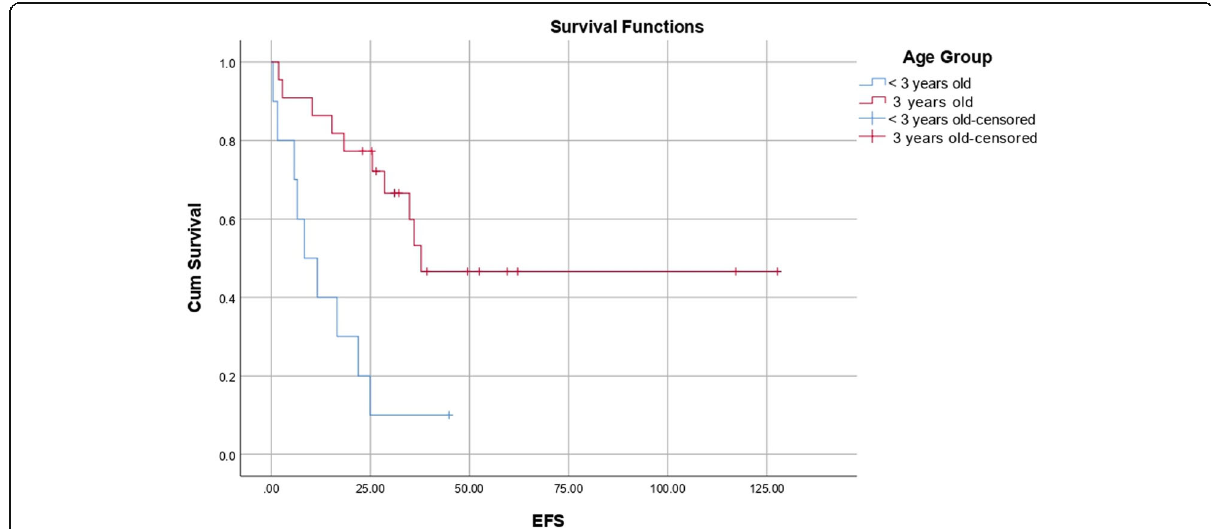
Fig. 1 Correlation between patients ’ ages and event-free